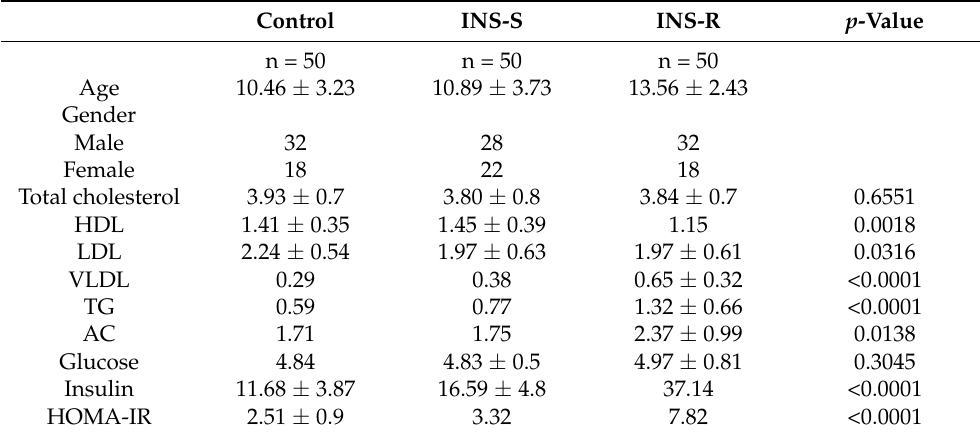
Table 1. Characteristics of the studied groups.